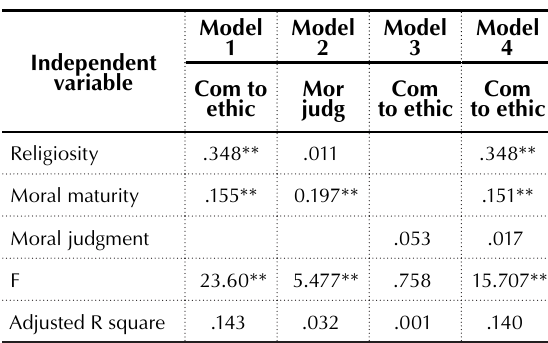
Table 2. Regression results